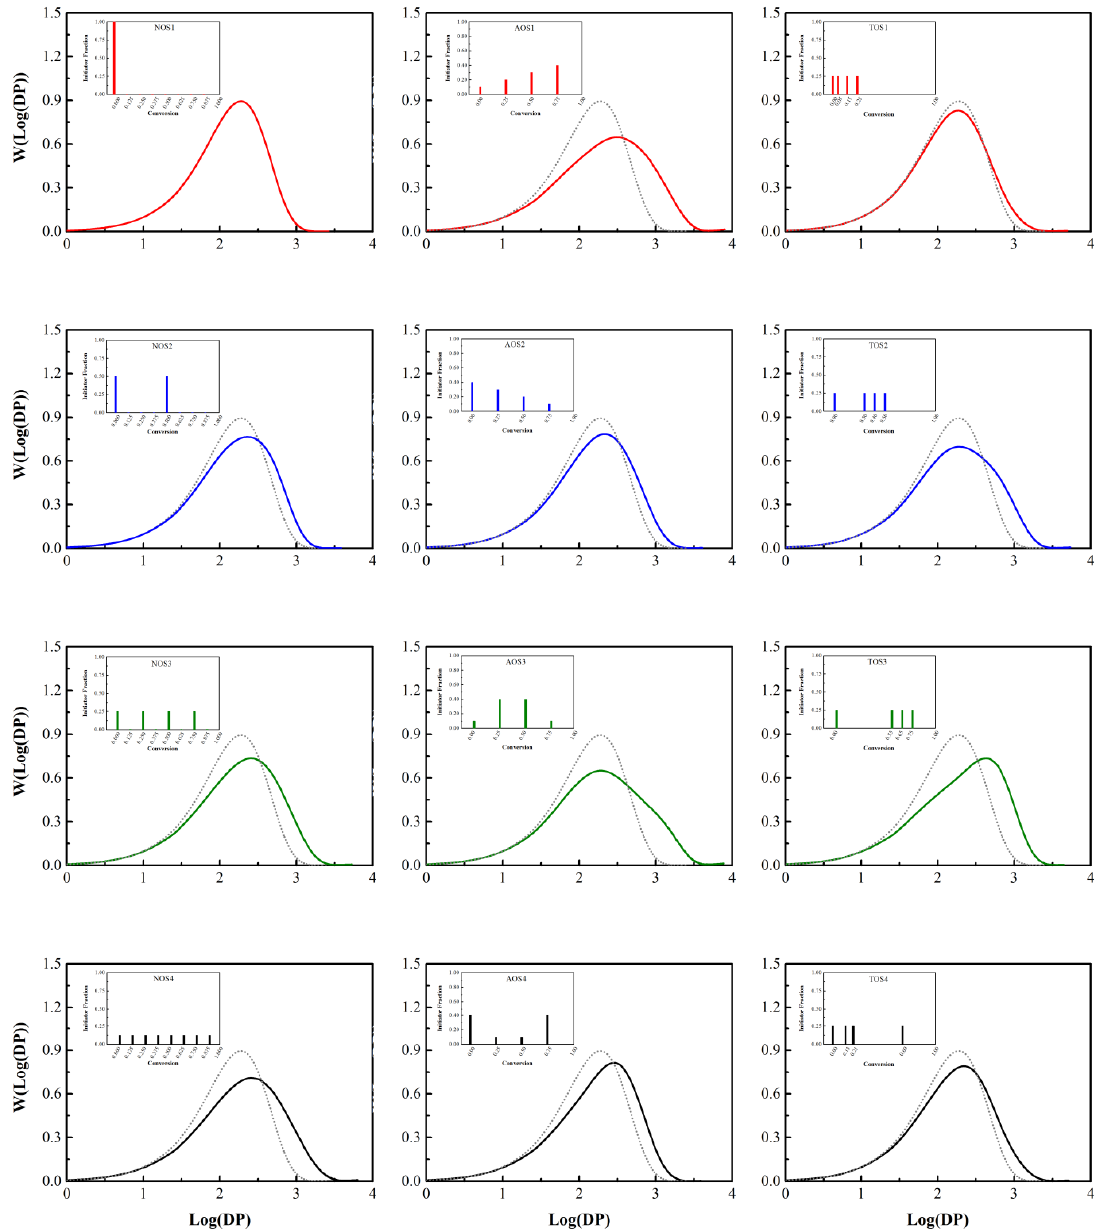
Figure 5. Final molecular weight distributions in semi-batch solution free radical polymerization of methyl methacrylate (Case 3) with [𝑀] 0 = 1.0 mol L –1 , [𝑆] 0 = 3.40 mol L –1 , [𝐼] 0 = 0.02288 mol L –1 , and a temperature of 70 °C for the three different initiator feeding policies (insets). Solvent mole fraction about 75%; S refers to solvent. Left column: NOS; middle column: AOS; right column: TOS. For comparison, the top left (NOS-1) result is presented in every other plot as a dotted line.